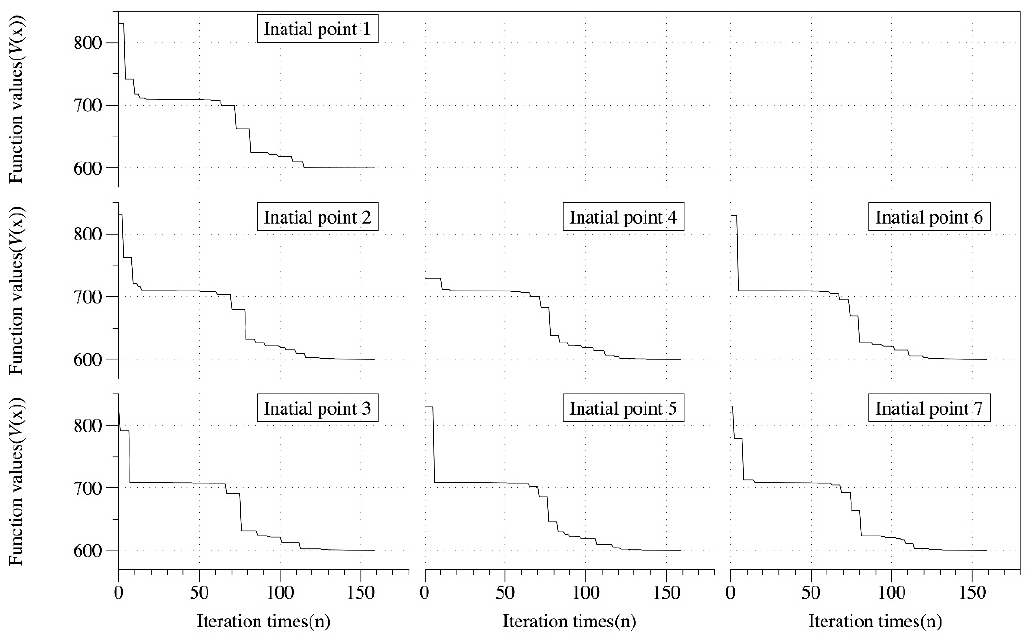
Figure 12. Initial points from matrix A with w scl = 0.04, w m = 0.96 and Thres = 0.001. Figure 11. Initial points from matrix A with